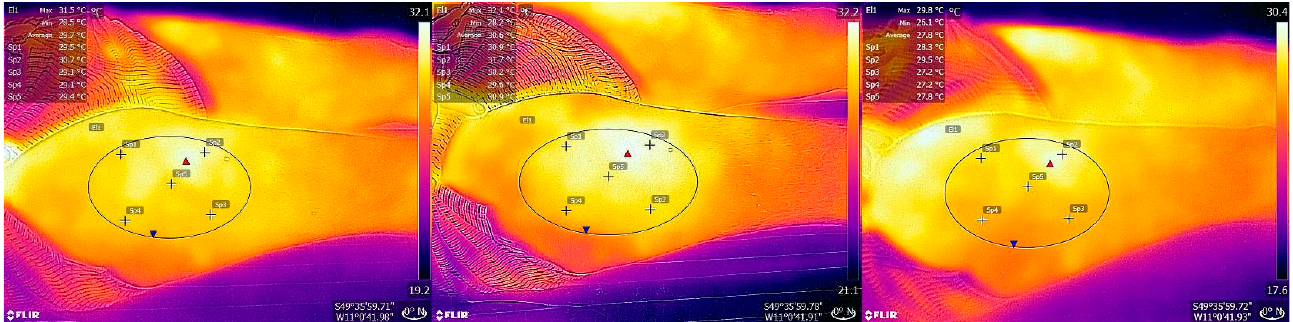
Figure 7. Thermography images from the control group, taken at t0 ( left ), t1 ( middle ), and t6 ( right ). Table 3. Overview of tissue temperature mean values at t0, t1, and t6, measured by thermography in Celsius degrees. Differences in tissue temperature between the main time points, with negative values representing a decrease in